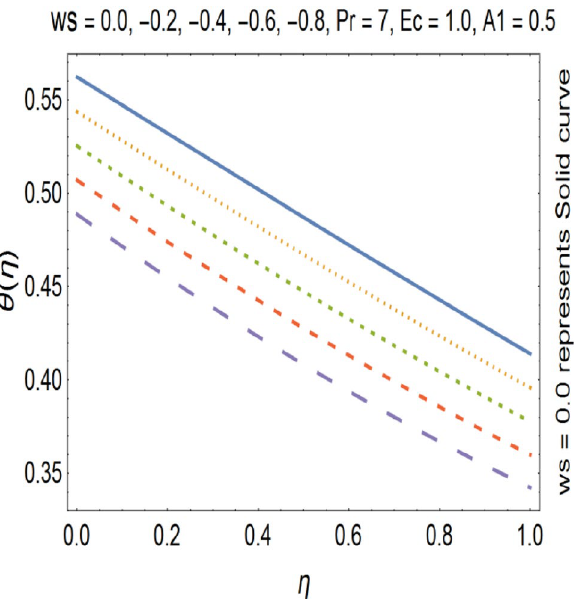
Figure 16. Temperature profile for various